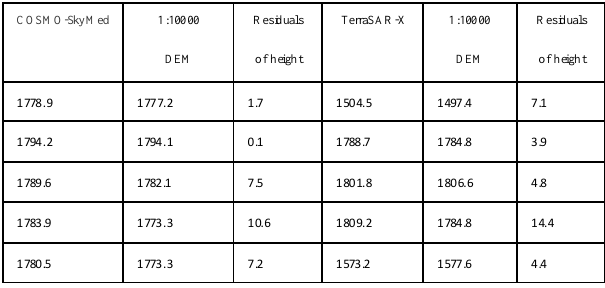
Table 2. accurate of